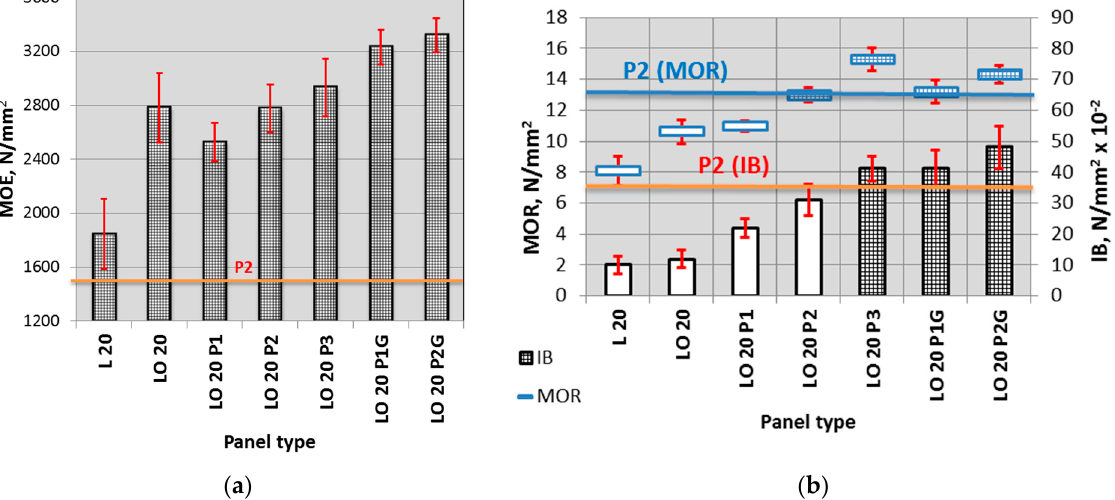
Figure 3. Experimental results on the mechanical properties of the particleboard made with lignin-based adhesives: ( a )